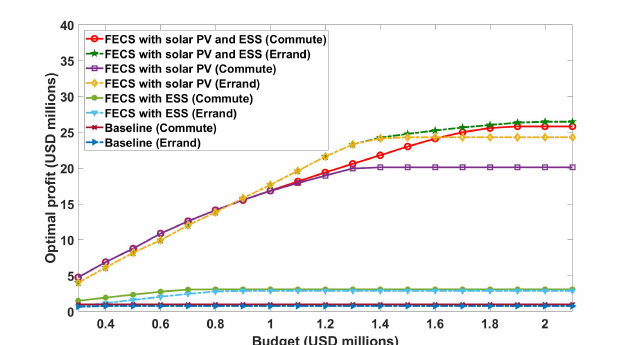
Figure 7. Sensitivity of the solar PV and ESS on the FECS all-inclusive cost